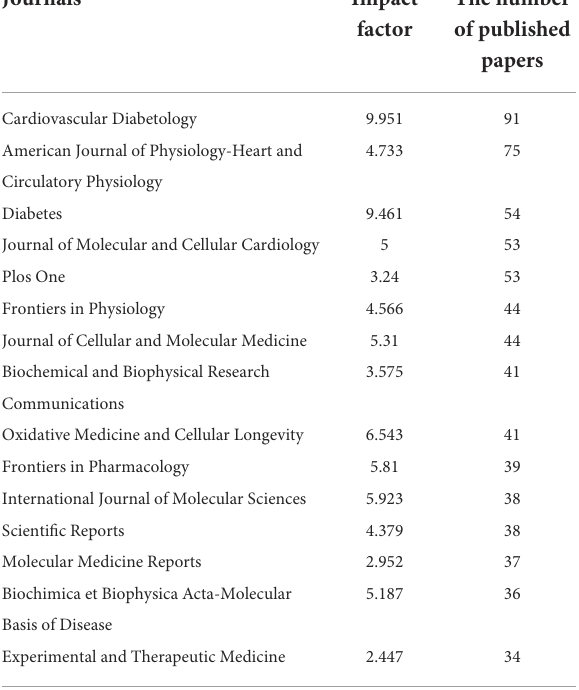
TABLE 1 Top 15 most productive